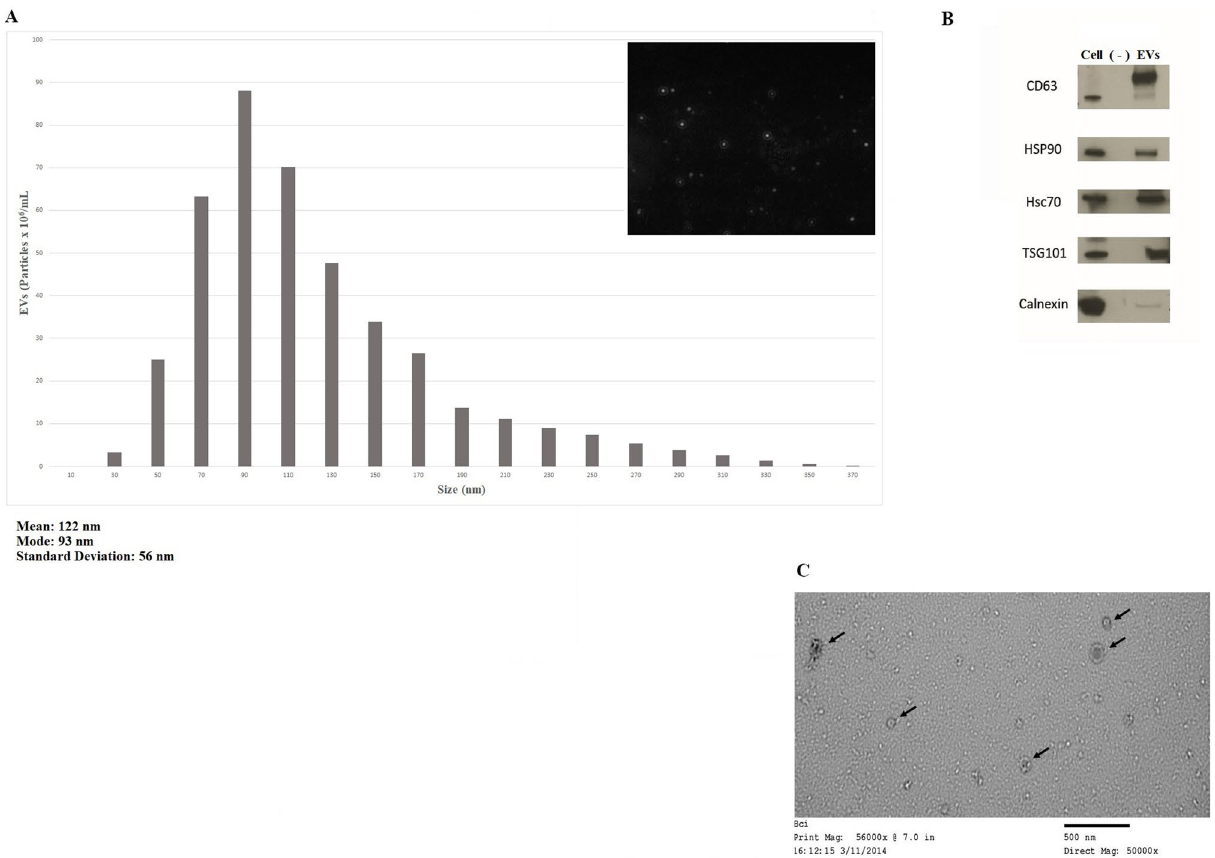
Figure 1. Characterization of EVs produced by immortalized human airway basal cells in culture. ( A ), Representative size distribution histogram of EVs isolated from conditioned media of BCi-NS1.1 cells grown in culture. The NanoSight NS500 machine with Nanoparticle Tracking Analysis software was used to calculate the quantity of particles as well as their size distribution (mean, mode, etc.). A representative image of the particles is shown in the upper right. ( B ), Immunoblots (cropped for clarity and conciseness) of BCi-NS1.1 cell lysates and EVs produced from these cells with antibodies against proteins found in exosomes—CD63, HSP90, Hsc70, and TSG101—as well as Calnexin, which is not typically seen in exosomes. Equal amounts of total protein were loaded into the cell-lysate and EV lanes. As a negative control, BEGM without BPE was incubated for 48 h in flasks without cells and then processed by means of the same procedures used to isolate EVs. A volume equal to that of the EV preparation was loaded onto the lane marked “(—)”. ( C ), Representative image of BCi-NS1.1 EVs (marked by arrows) taken using electron